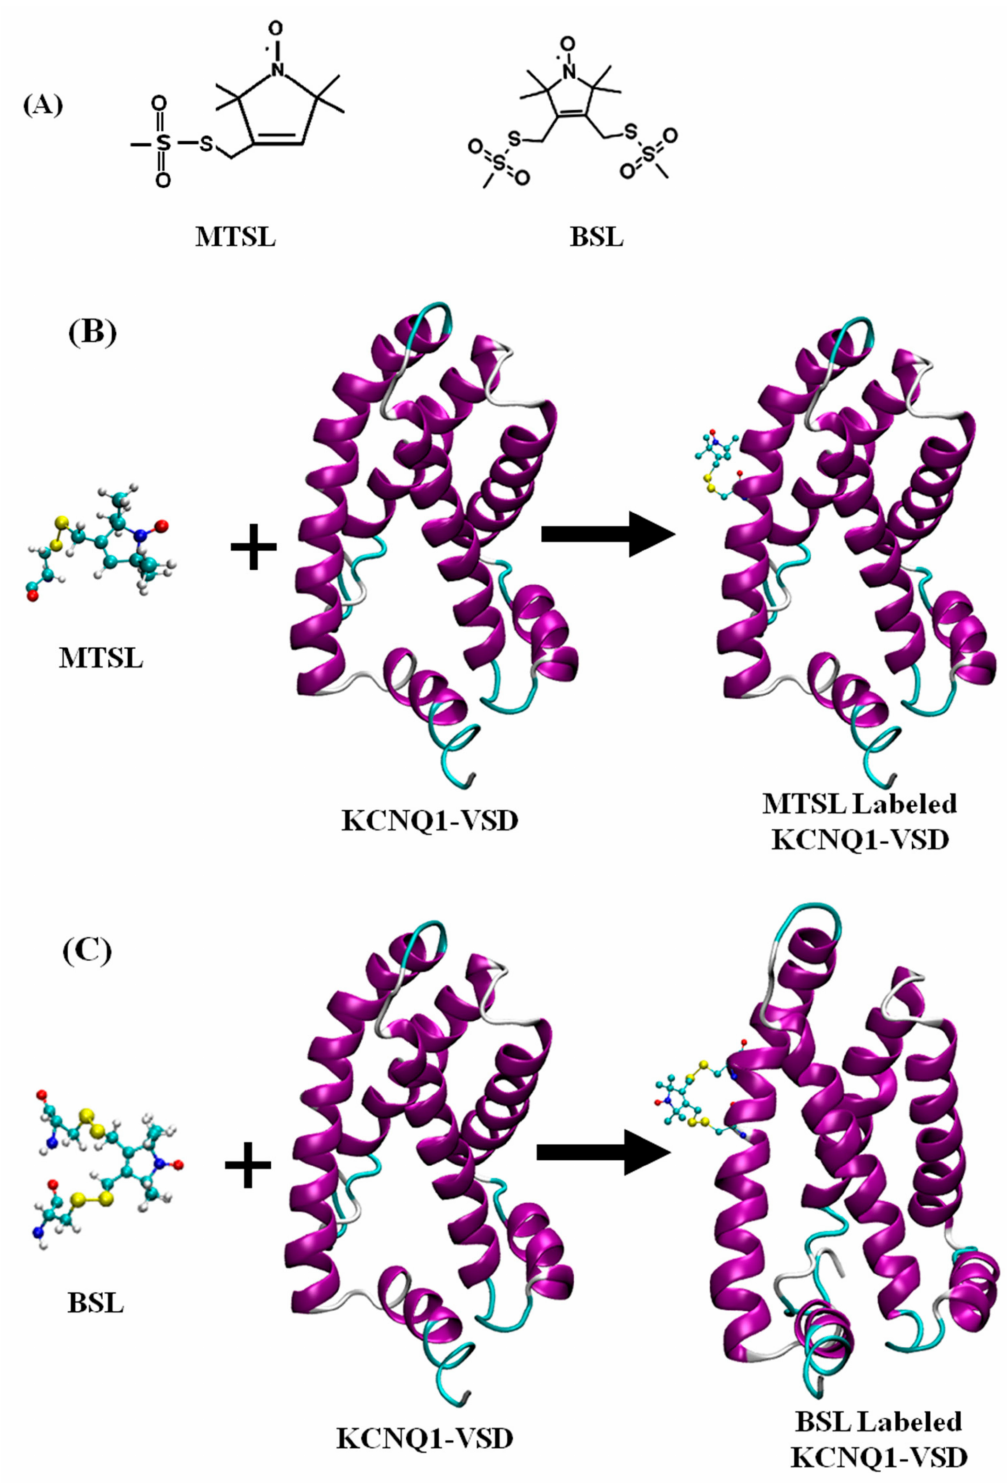
Figure 2. ( A ) A chemical structure of MTSL (methanethiosulfonate spin label) and BSL (bifunctional spin label). ( B ) Cartoon representation of the structure of MTSL and the resulting side-chain produced by reaction with a cysteine residue (L134C) and ( C ) the structure of BSL (bifunctional spin label) and the resulting side-chain produced by reaction with cysteine residues (L134C and I138C) on a KCNQ1-VSD membrane protein. The incorporation of MTSL and BSL spin labels on KCNQ1-VSD (PDB ID:6MIE) was obtained using Charmm-GUI (http://www.charmm-gui.org, accessed on 6 March 2021) [34]. The cartoon structure of the MTSL-labeled and BSL-labeled KCNQ1-VSD was rendered using visual molecular dynamics (VMD)